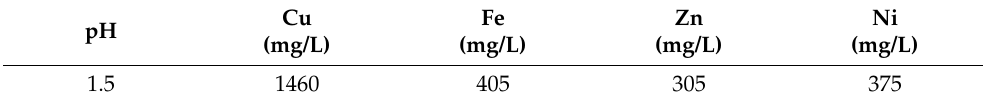
Table 5. Analysis of the pregnant solution after solvent extraction with ACORGA M5640 in one stage.